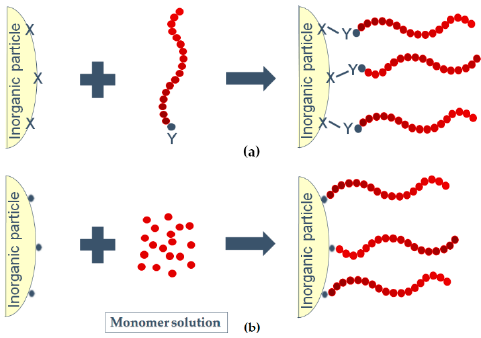
Figure 6. Schematic representation the surface functionalization of inorganic particles by ( a ) “grafting onto” and ( b ) “grafting from” reactions (Redraw and adapted figure from [72]).